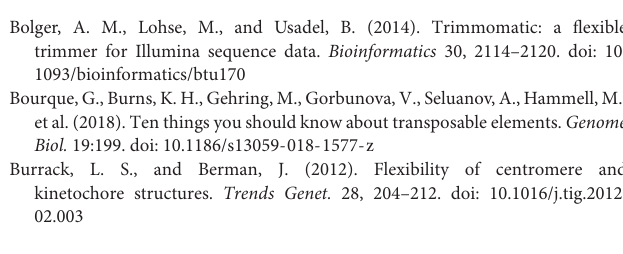
Supplementary Figure 1 | Summary of the contents of the repeat family and single copy reads in S. officinarum LA Purple (A) and S . spontaneum clone SES208 (B) . Supplementary Figure 2 | FISH mapping of repeats LA38C21, LA65C19, and LA4C35 in LA Purple. FISH results showed that repeats LA38C21, LA65C19, and LA4C35 were dispersed in the genome of LA Purple. Bars = 10 µ m. Supplementary Figure 3 | FISH mapping of repeat Se1C692 and chromosome 7 painting probe in SES208. Probes of chromosome 7 and Se1C692 were hybridized to a somatic metaphase cell of SES208. The merged images from (A,B) demonstrated monospot signals from the centromeres of all eight chr7 homologous chromosomes. Individual chromosomes bearing chromosome 7 painting FISH signals are bracketed using dotted lines in (B) . Bar = 10 µ